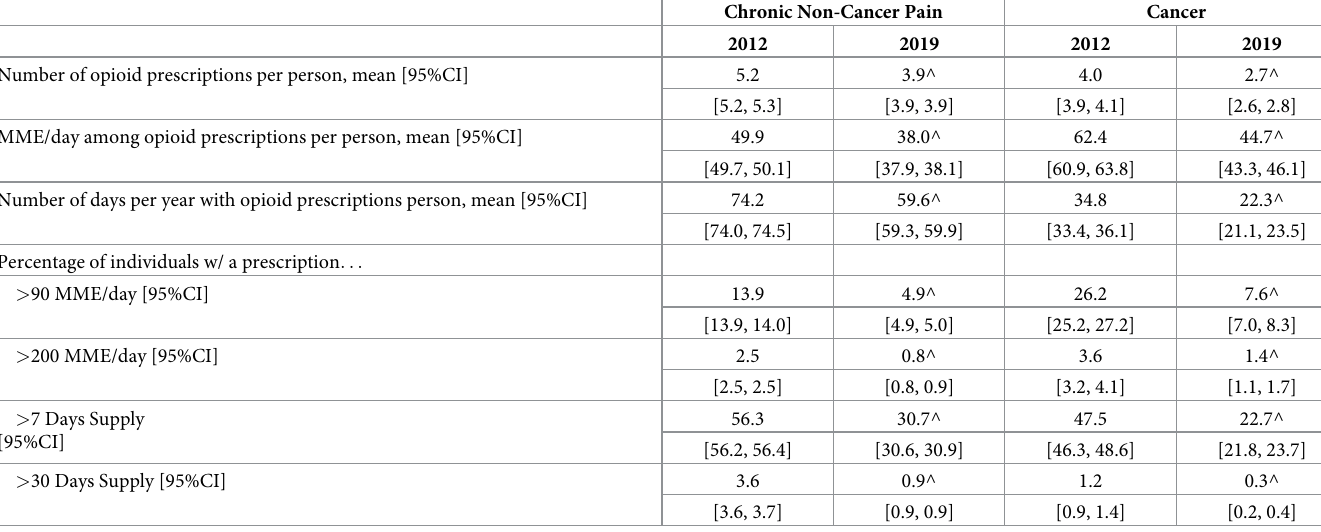
Table 2. Opioid prescription characteristics among individuals with chronic non-cancer pain or cancer who received an opioid prescription, 2012–2019. Chronic Non-Cancer